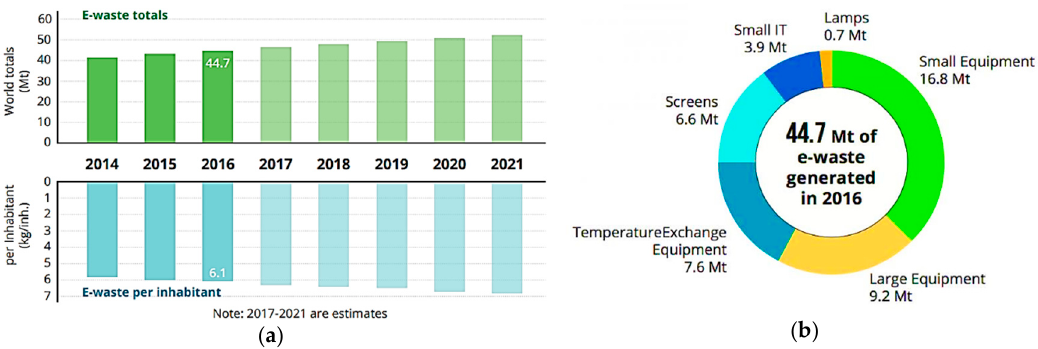
Figure 1. ( a ) Amount of global e-waste generated from 2014 to 2016 and values estimated for the following years (2017 to 2021) and ( b ) typology of e-waste produced in 2016. Adapted from Baldé et al. (2017) [18], with permission from ITU, 2017.